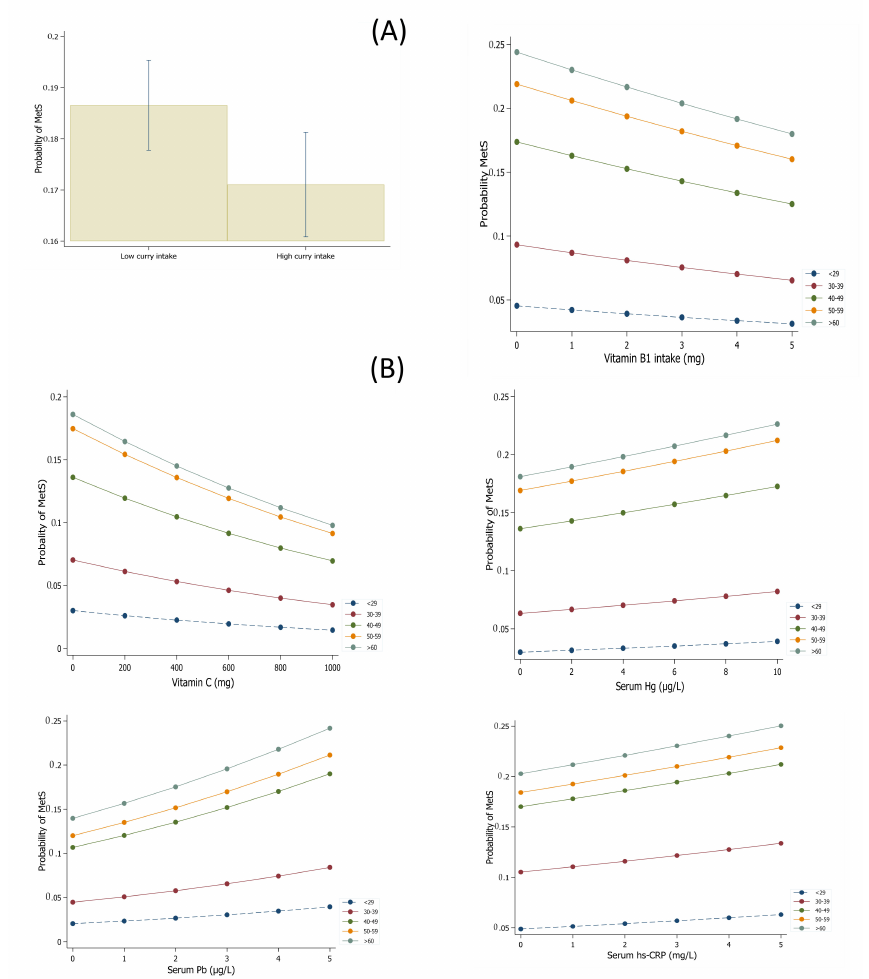
Figure 2. Marginal effects of vitamin intakes, curry consumption ( A ), and serum levels of heavy metals and hs-CRP ( B ) on MetS by age group in the Korean population after adjustment for poten- tial